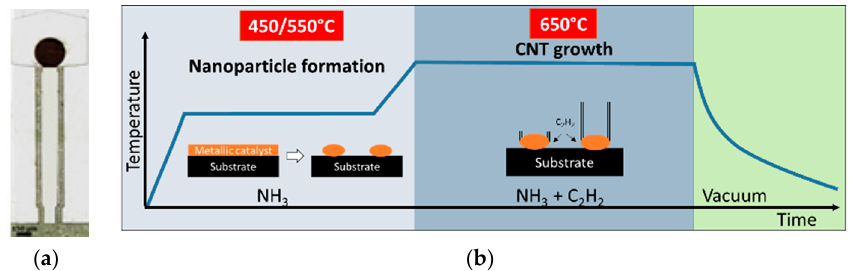
Figure 2. Growth of CNT forest on the metallic top electrode of SMRs ( a ) Optical top view of a device with CNTs grown on its active area; ( b ) Steps of the CVD growth process.